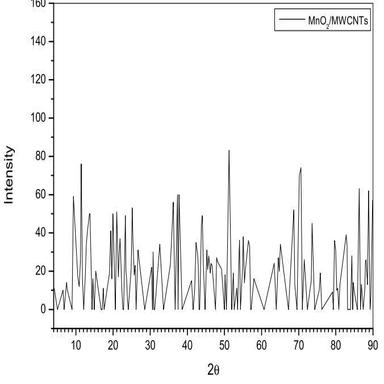
XRD pattern of mesoporous (MnO2/MWCNT).